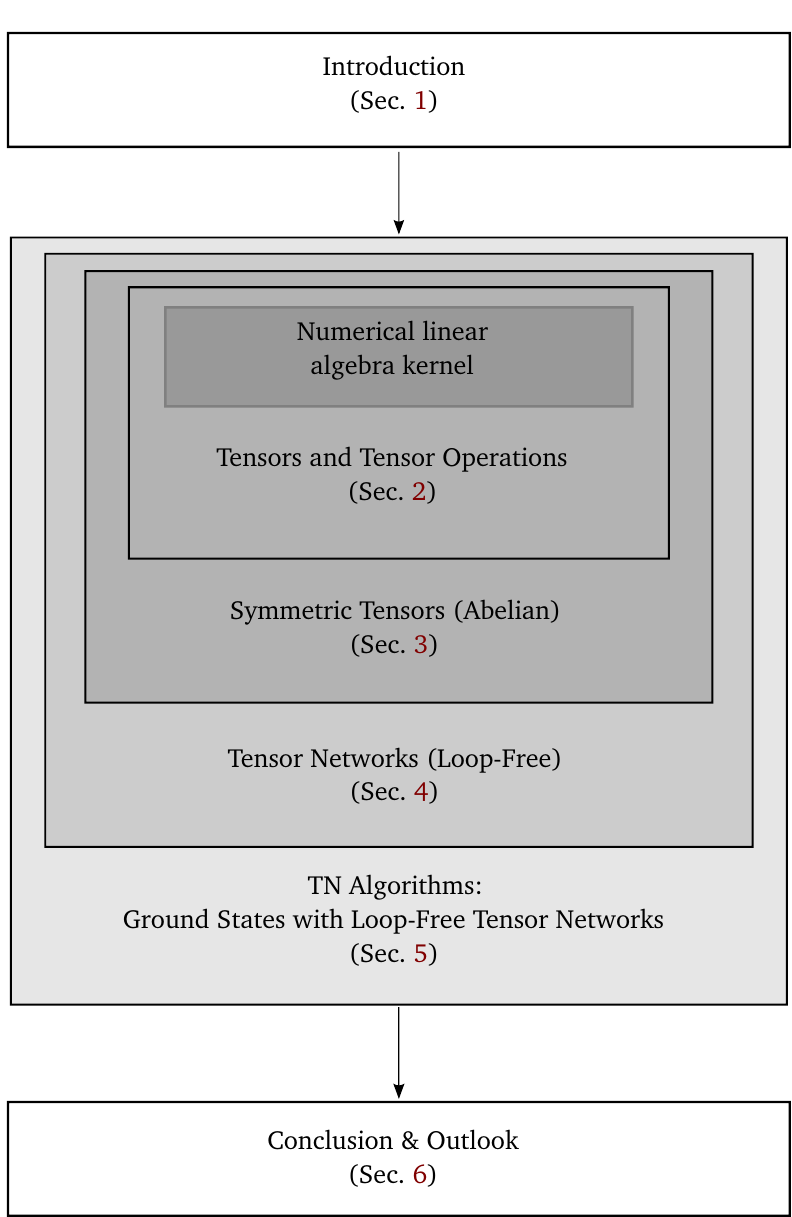
Figure 1: Organization of the anthology. In an embedded-boxes structure, the introduction is followed by a self-consistent treatment of elementary tensors and tensor-operations plus their extension in presence of symmetries. On this foundation we build up and investigate (loop-free) tensor networks and algorithms. The parts about symmetries are optional and can be skipped. As this manuscript is intended as a practical anthology, the structure is chosen such that it can be directly mapped into numerical libraries, organized in the same hierarchy, starting from a kernel of numerical linear-algebra routines which are widely available and thus not covered in this